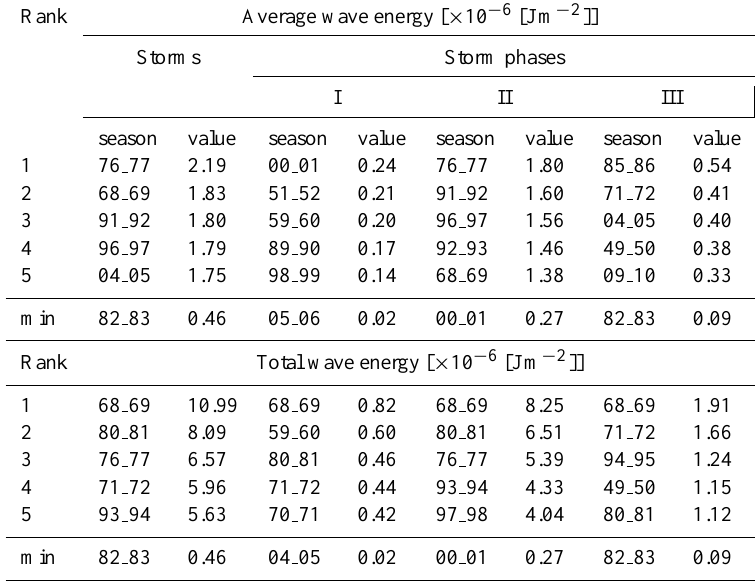
Table 2. The five most and the one least intensive storm seasons within the study period 1948–2010, ranked according to average and total values of the wave energy